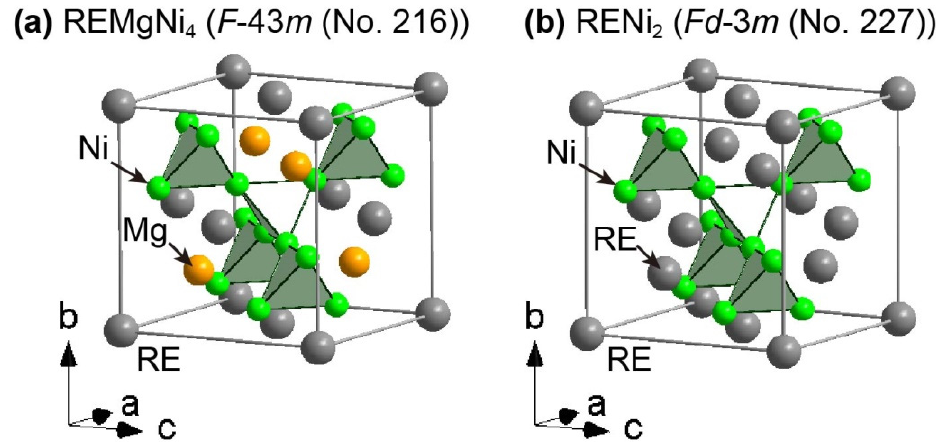
Figure 1. Crystal structures of ( a ) REMgNi 4 in the space group ( F -43 m (No. 216) and ( b ) RENi 2 in the space group Fd -3 m (No. 227, origin choice 1). Crystal structures of REMgNi 4 and RENi 2 were drawn based on crystallographic parameters of Y 1.06 Mg 0.94 Ni 4.00 [20] and YNi 2 [37], respectively. The RE, Mg, and Ni atoms are represented by grey, orange, and green spheres, respectively. The differences between the two crystal structures are apparent at the (0, 0, 0) and (1/4, 1/4, 1/4) atomic sites. In the REMgNi 4 , the RE and Mg atoms are located at